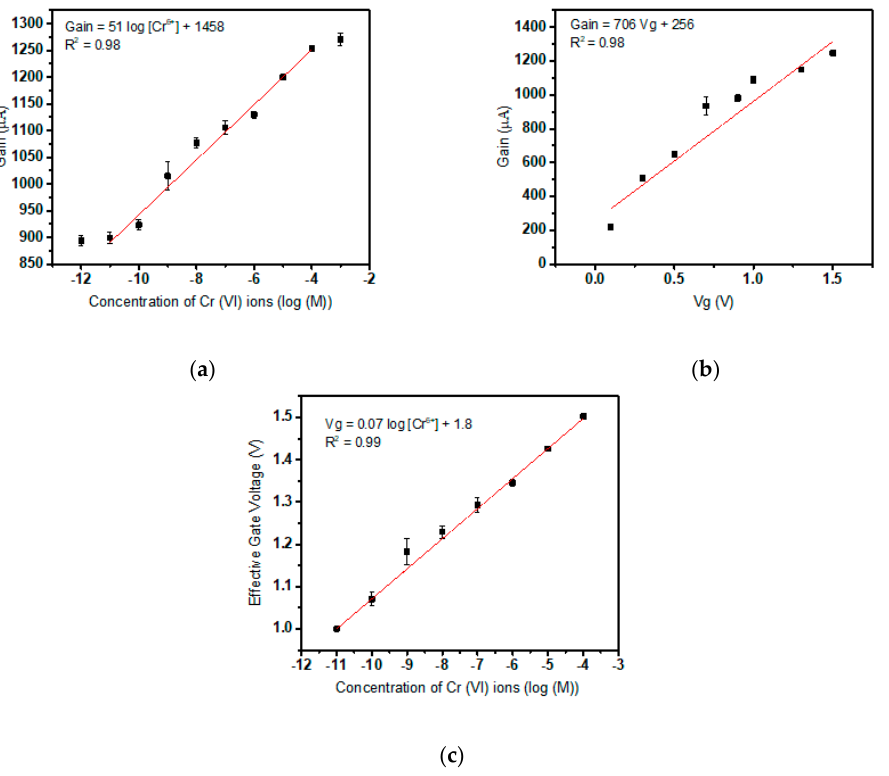
Figure 5. ( a ) Cr(VI) selective sensor gain versus concentration plot; ( b ) Effect of applied gate voltage depicted as gain versus V g ; ( c ) Sensitivity plot of the Cr(VI) selective biosensor.